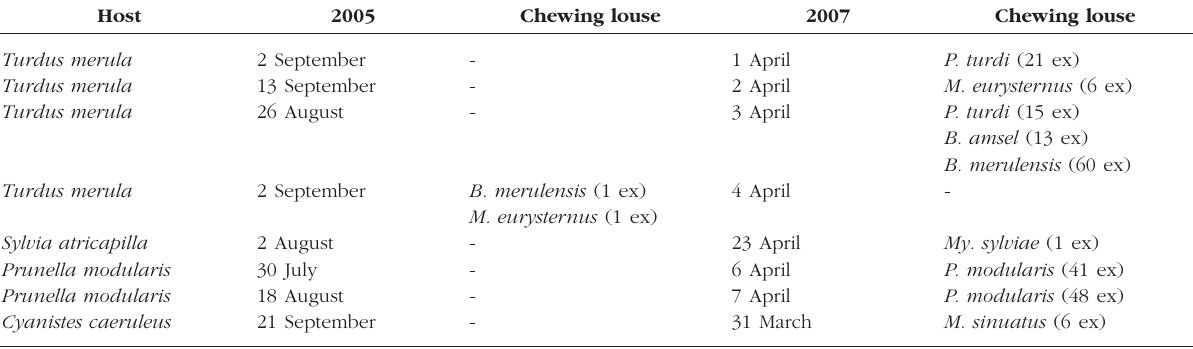
Table II. – Individual birds examined in both post-breeding (2005) as well as pre-breeding periods (2007) and their chewing lice.